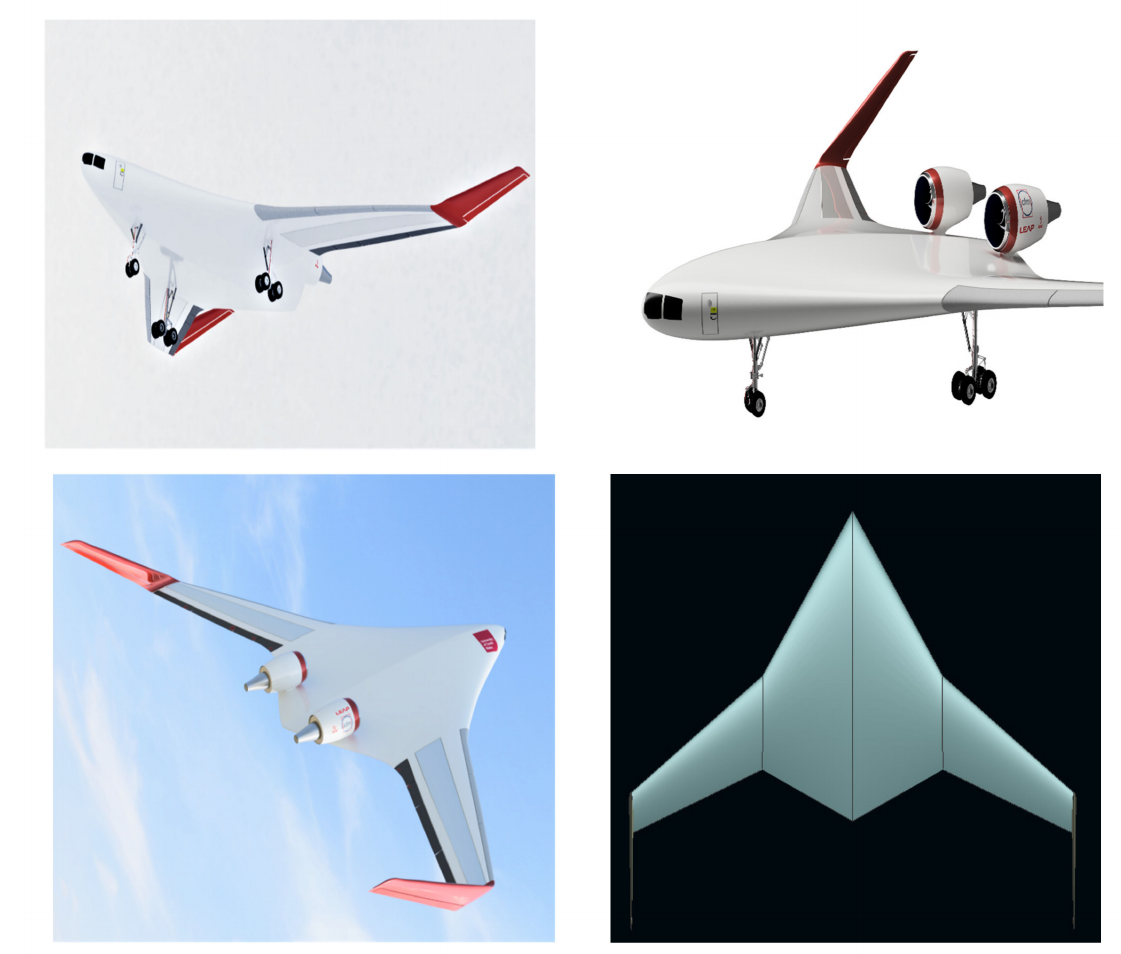
Figure 5. Various views of the re-shaped